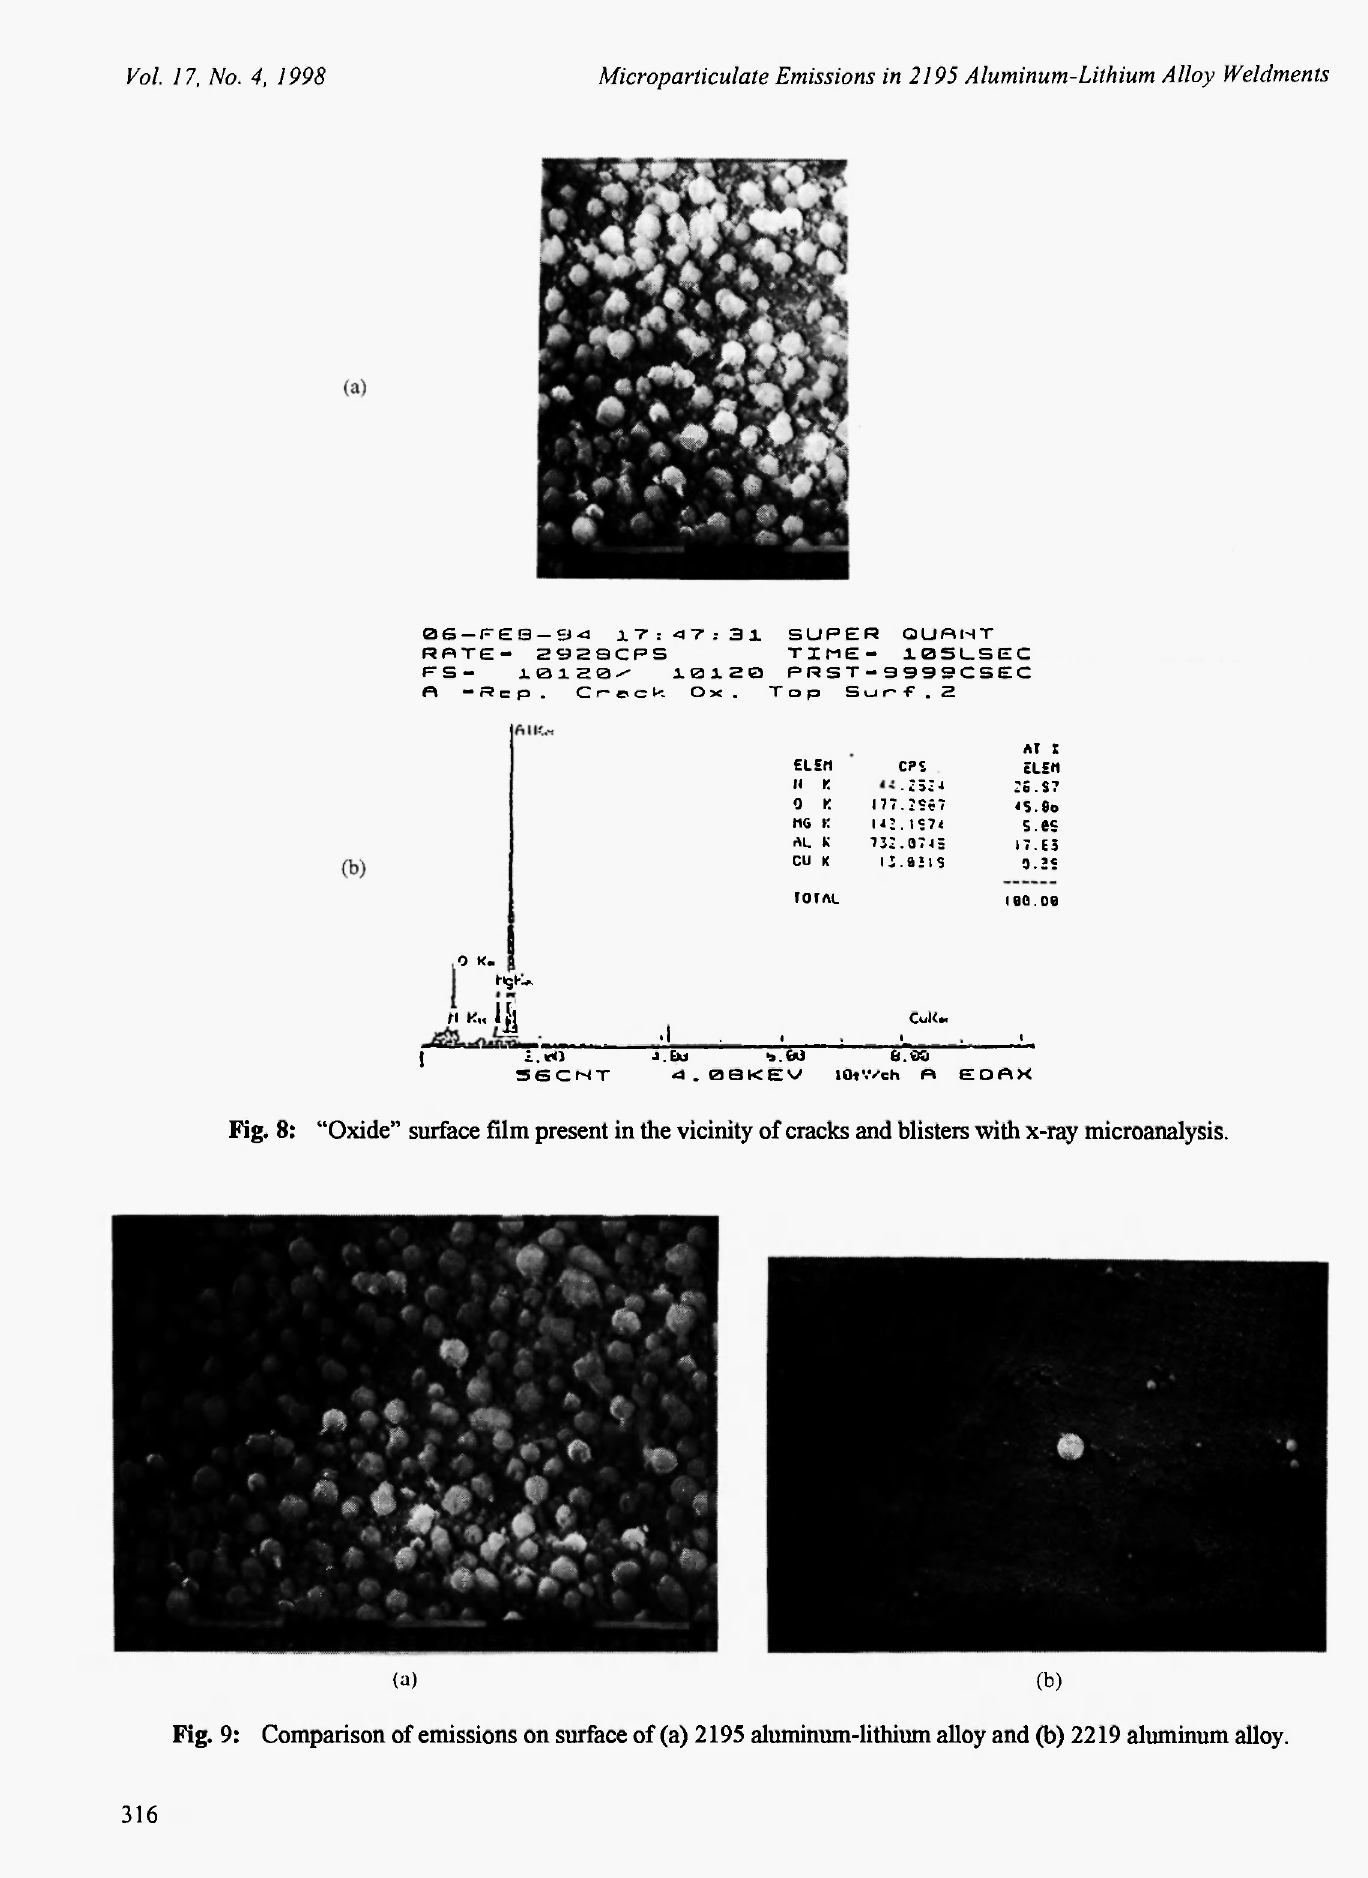
Fig. 8: "Oxide" surface film present in the vicinity of cracks and blisters with x-ray microanalysis.